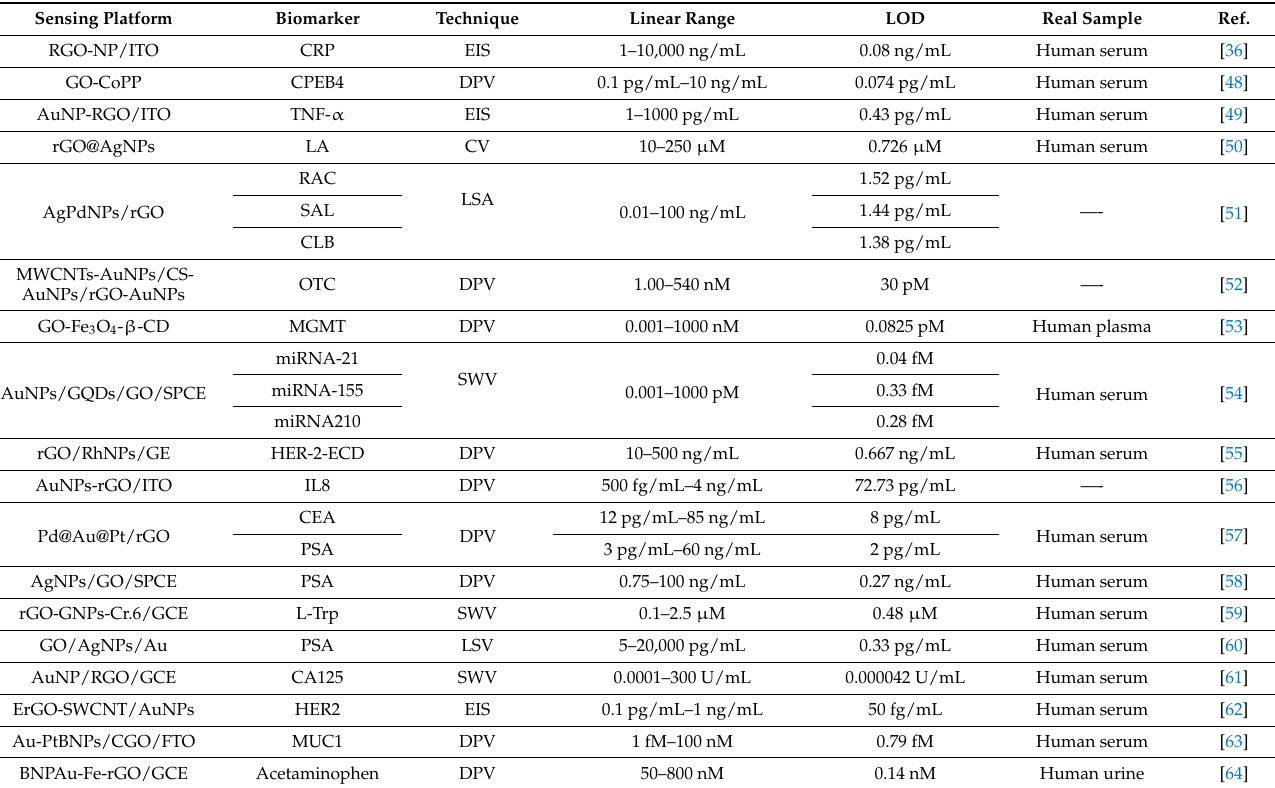
Table 1. Literature reports on the analytical parameters of graphene oxide conjugated nanoparticles for various biomarker